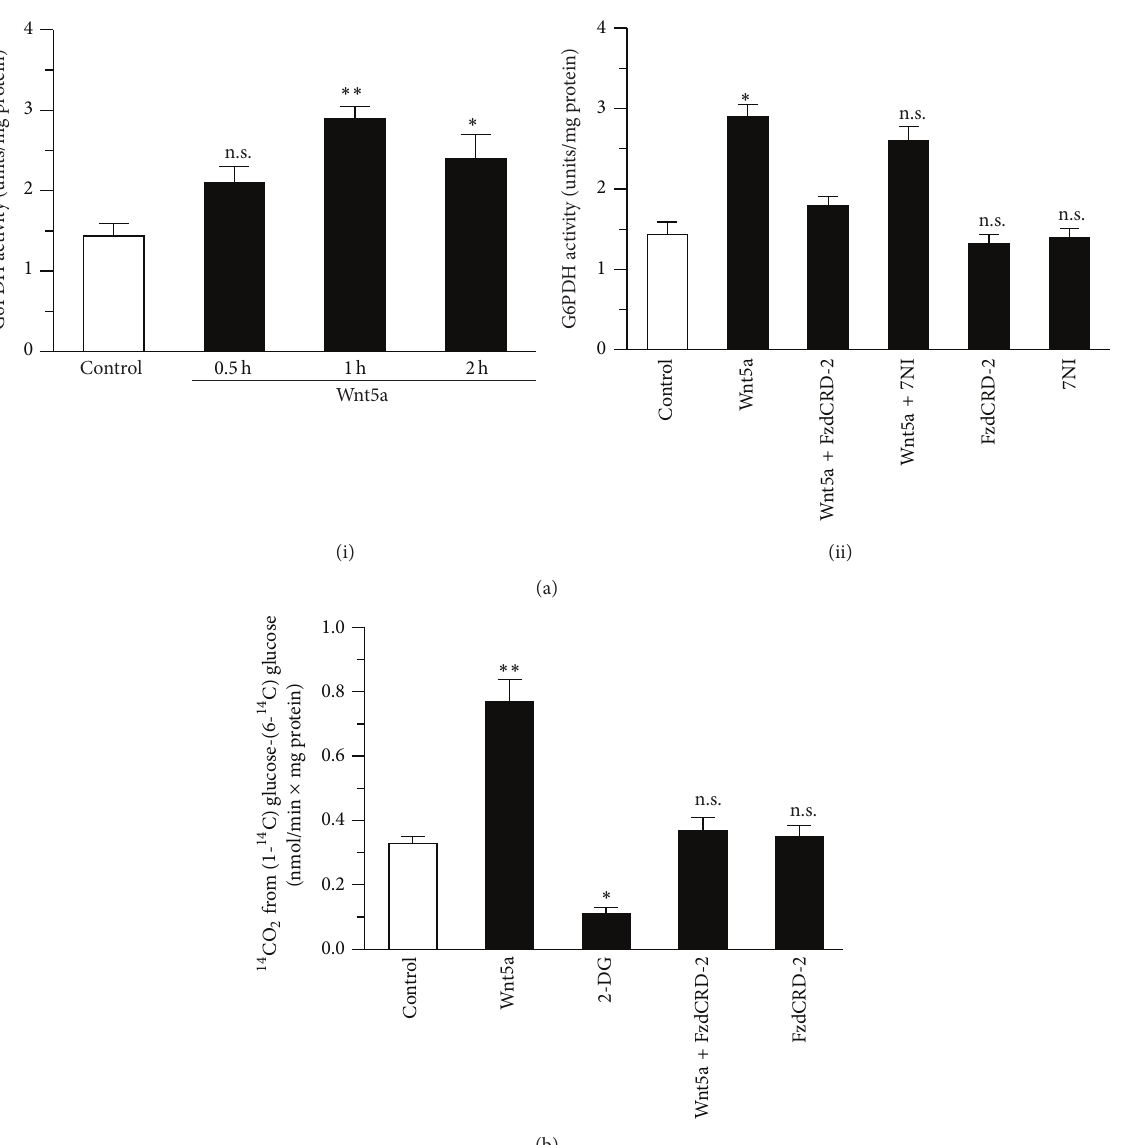
Figure 3: The Wnt5a stimulates the PPP activity. (a) The activation of Wnt pathways increases the activity of G6PDH in a time-dependent manner (i); this effect was blocked by the coincubation with FzdCRD-2 and 7NI (ii). (b) The oxidation of glucose through PPP pathway was stimulated after the treatment with Wnt5a; this effect was blocked by the coincubation with FzdCRD-2. Data represent the mean ± SEM of 𝑛 = 5 , each performed in triplicate. ∗ 𝑝 < 0.01 ; ∗∗ 𝑝 < 0.005 , Bonferroni test.